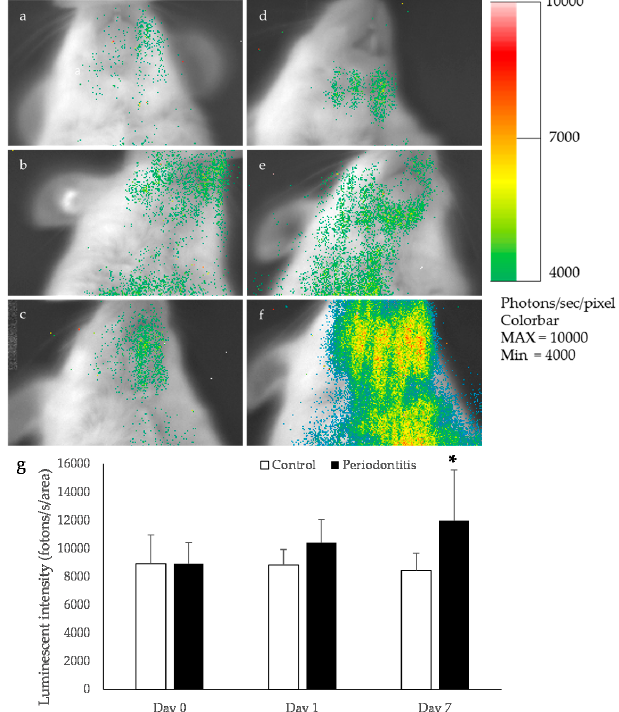
Figure 3. Bioluminescence imaging in oxidative stress detector-luciferase (OKD-LUC) mice. The color scale bar shows the photon counts. Representative photographs taken at baseline ( a ); the control group at day 1 ( b ) and day 7 ( c ); the periodontitis group just after ligation ( d ); and the periodontitis group at day 1 ( e ) and day 7 ( f ). In the periodontitis group, a high luminescence intensity was observed in the mandibular area at day 7 ( d ). This luminescence intensity was significantly higher in the periodontitis group than in the control group (* p < 0.05, t -test) ( n = 6/group) ( g ). Using an Nrf2 nuclear translocation assay, the nuclear level of Nrf2 was investigated using immunofluorescence staining to support the data of luminescence intensity. Nuclear Nrf2 was minimally expressed in the control group. It was observed more frequently in areas adjacent to the alveolar bone surface within the periodontal ligament in the periodontitis group (Figure 4).